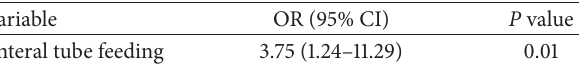
Table 5: Factors associated with poor prognosis ∗ among 75 hospi- talized adult patients with Clostridium difficile colitis according to multivariate logistic